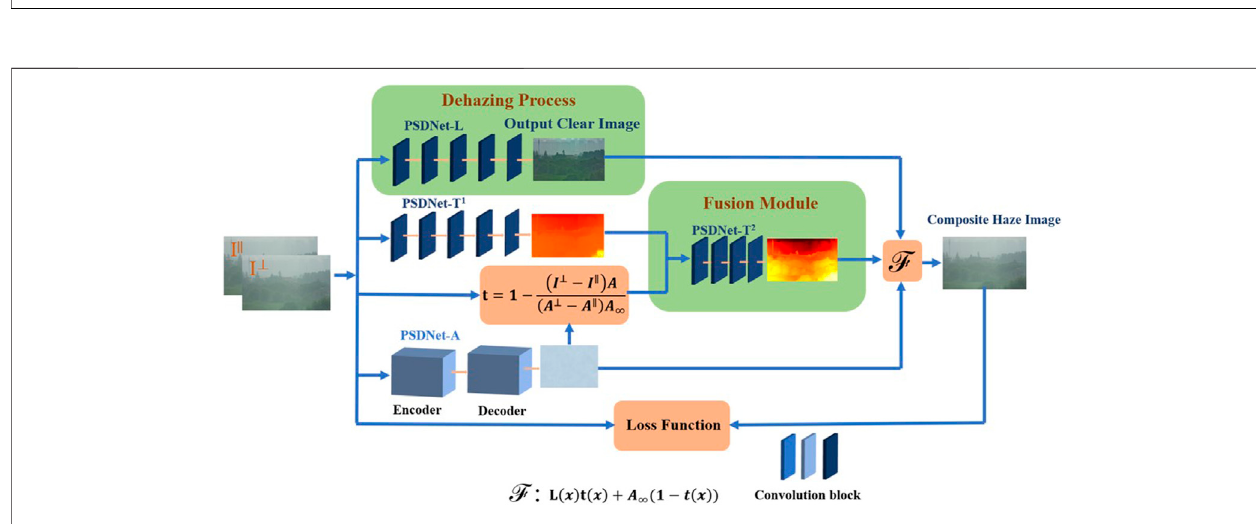
FIGURE 6 | Cross-scene dehazing capability comparison. (A) Pre-training scene 1 . (B) Pre-training scene 2 . (C) Scene 3 to be dehazed. (D) Dehazing results by using the DCP-based method. (E) Scene 3 dehazing results by using the scene 1 training model for direct inference. (F) haze removal results using the training model of scene 2 as a pre-training model and 25 gradients are back-propagation for updates. The distant scenes with severe image degradation are locally zoomed in and edge extraction is performed to compare the dehazing ability of different methods.